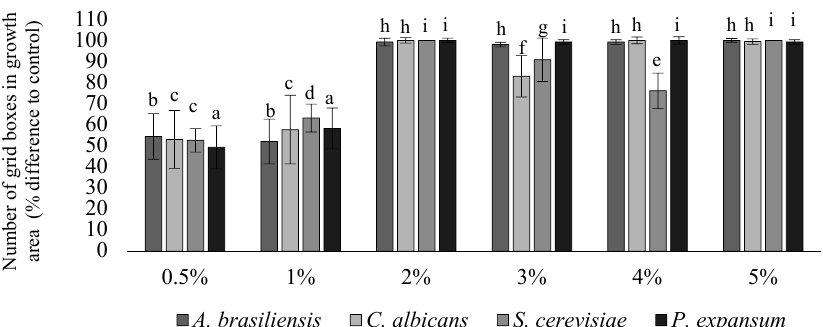
Figure 2. Assessment of fungal growth on samples with 0.5–5% biocide content (x-axis) using a growth area grid according to ISO 846:2019 [7] (percentage difference fromcontrol). All values are statistically significant in relation to the control samples. Statistically significant differences between the variants in the diagram are marked with different letters, for p < 0.05.